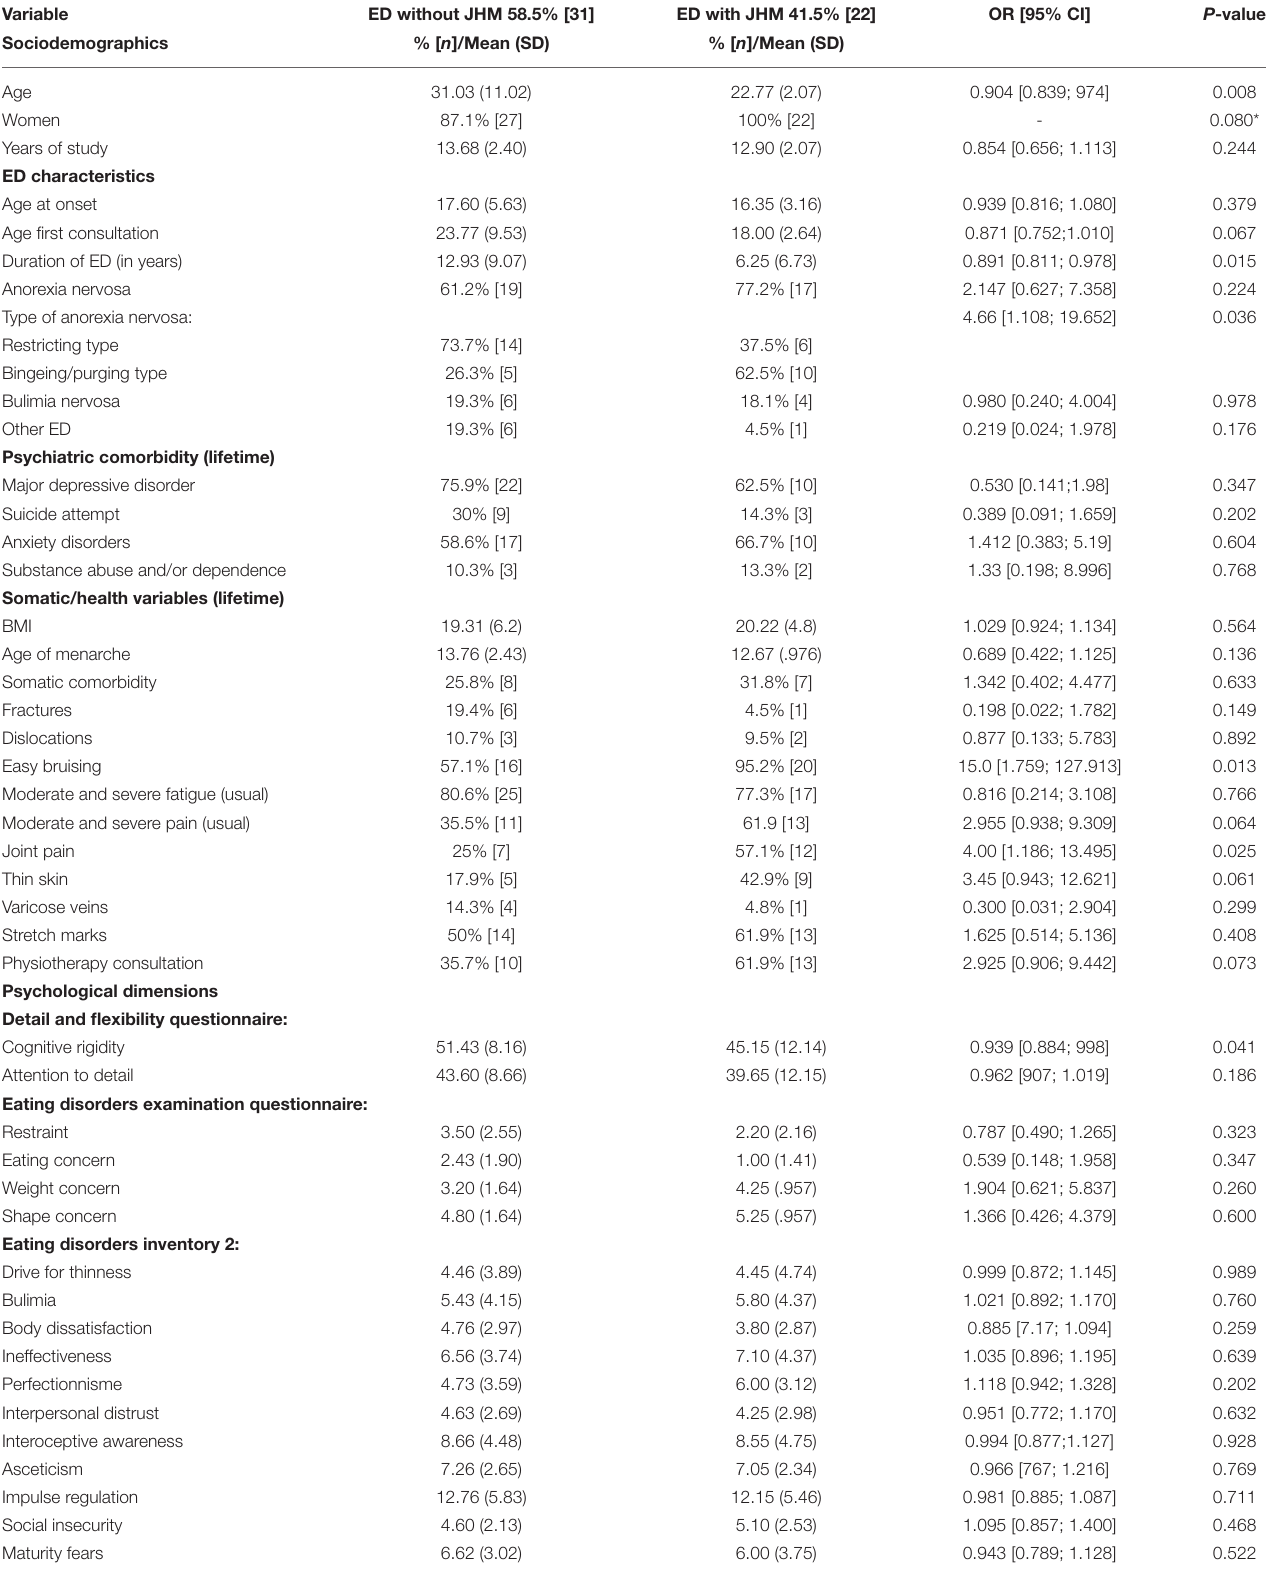
TABLE 1 | Comparison of characteristics between ED patients with and without JHM.